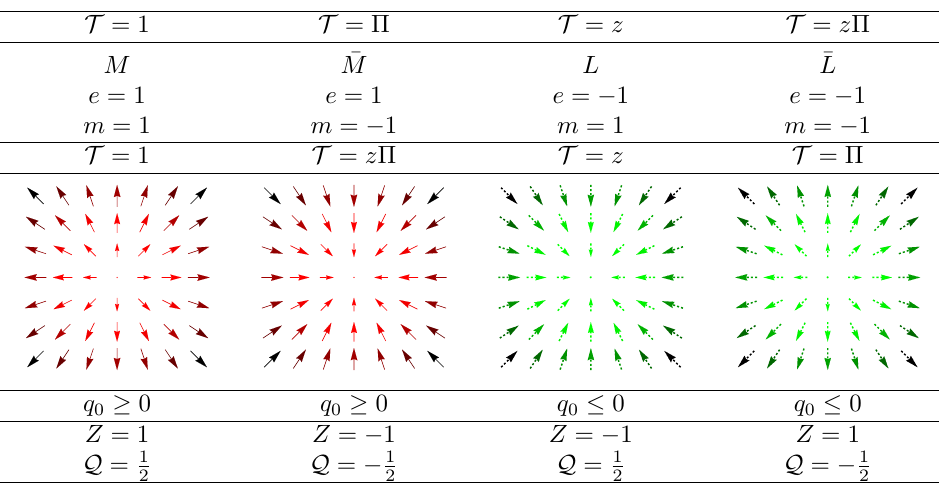
Table 1. Schemes of the four different topological possibilities of spherically symmetric hedgehogs for unit quaternions approaching q = 0 at infinity. The diagrams show the 0 imaginary components ~q of the quaternionic field, in full red for the hemisphere with q 0 0 > and in dashed green for q 0 and approach black towards q = 0. They differ by parity 0 < 0 transformations Π and center transformations z . The caloron constituents were dubbed M and L [4] according to their electric e and magnetic m charges in SU(2) Yang-Mills theory. In the solitonic interpretation they get the charge numbers Z and the topological charge Q for electrons and positrons with spin up and spin